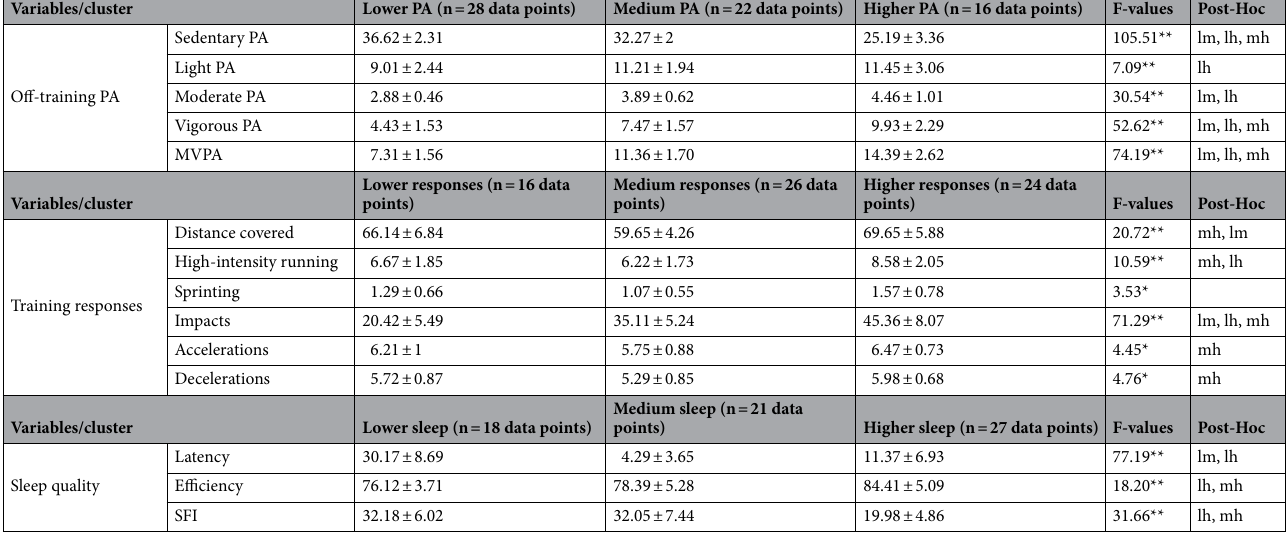
Table 1. Means, standard deviations and predictor importance from the obtained clusters. Lm statistically significant differences between lower and medium groups, lh statistically significant differences between lower and higher groups, mh statistically significant differences between medium and higher groups, PA physical activity. *Statistically significant differences at p < 0.05; **Statistically significant differences at p <